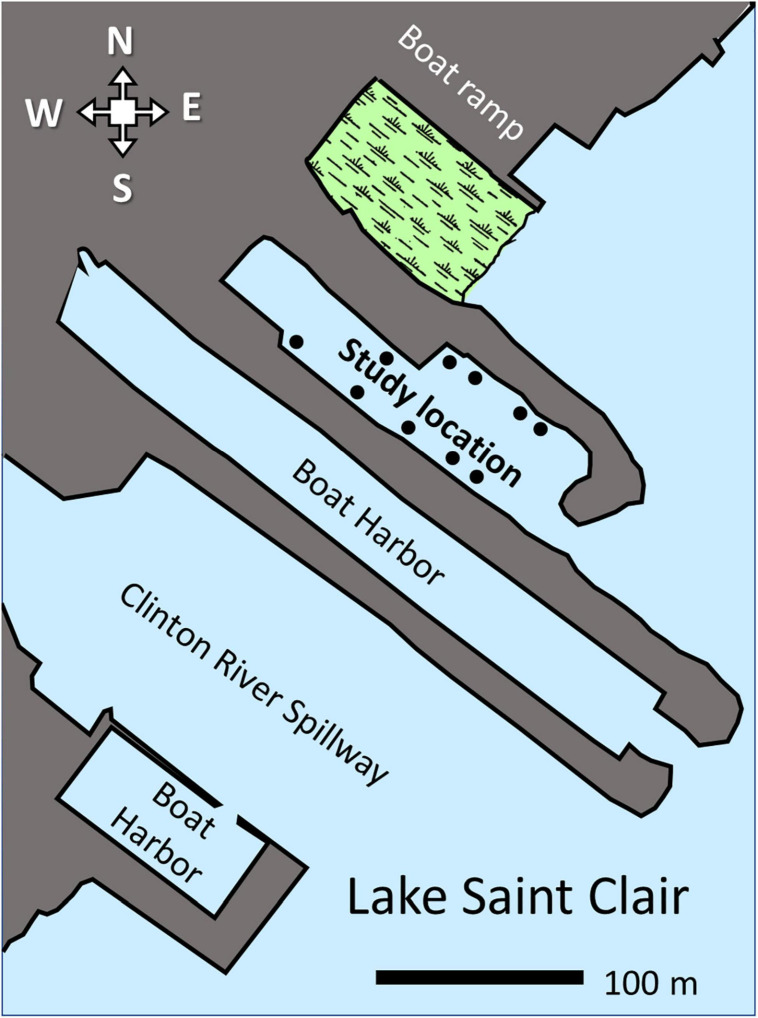
Map of the study’s location. Dots represent water sampling locations. Wetland contiguous to the study site is shaded in green. The range bar is 100 m.